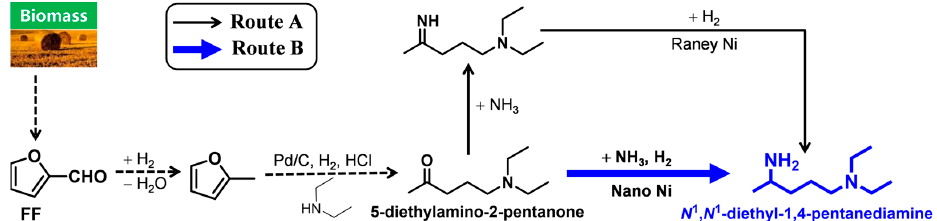
Figure 6. Reductive amination of FF-derived 5-diethylamino-2-pentanone and NH 3 . Adapted with permission from ref [55]. Copyright 2022 American Chemical